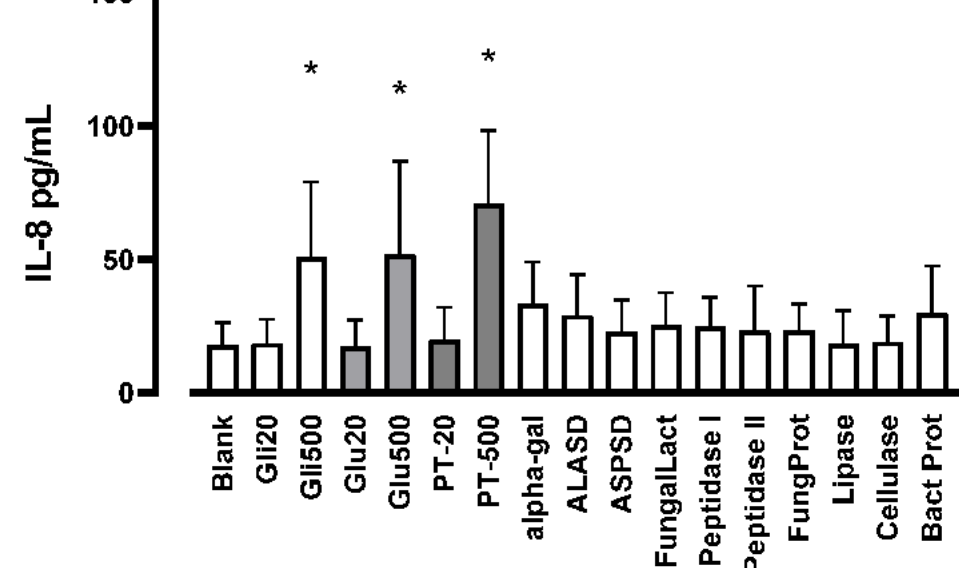
Figure 2. 500 ppm of crude gliadin, gluten and pepsin-trypsin digested gluten evoked an increase in IL-8 protein expression in THP-1 cells. There was no significant effect of commercially available enzyme supplements on IL-8 levels. * represents significant difference as compared with the 20 ppm comparator group, p < 0.05.